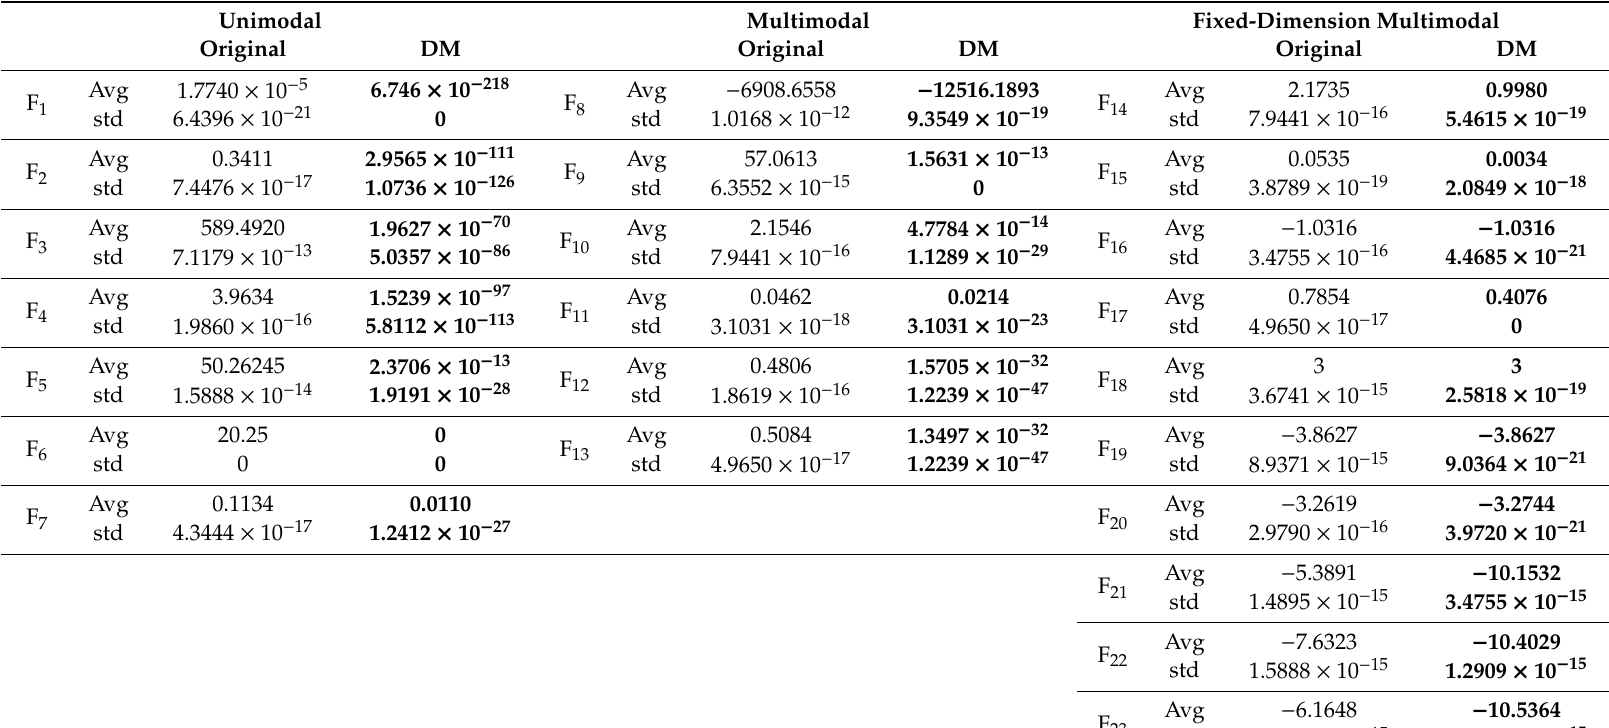
Table 3. Optimization results of particle swarm optimization (PSO) for original and “modified by DM”